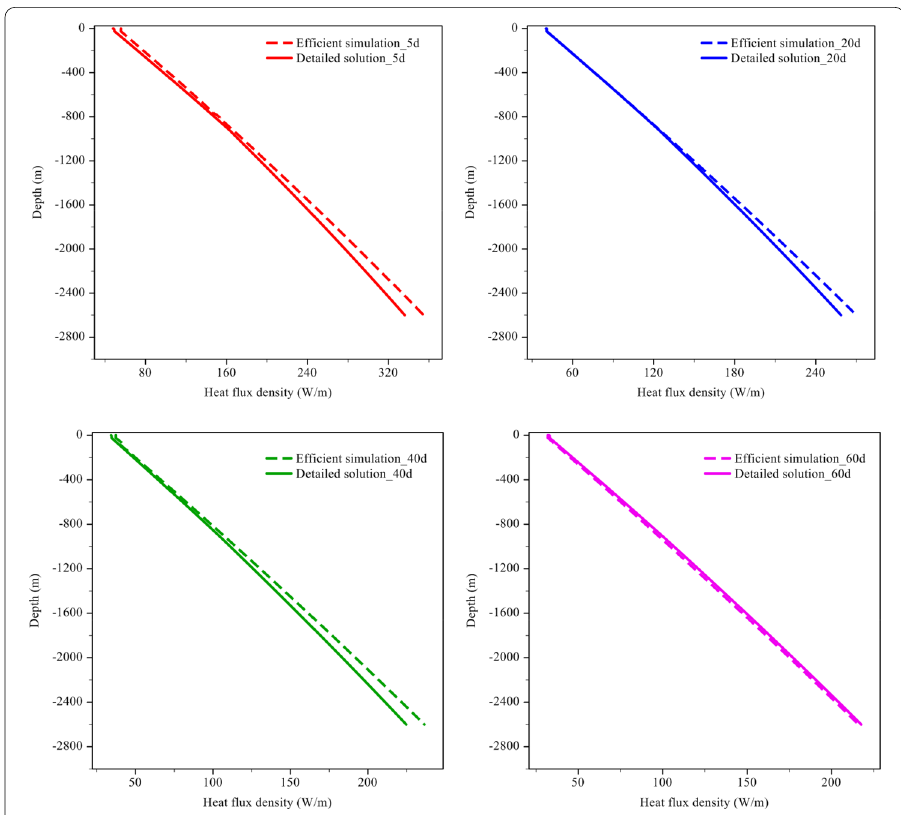
Fig. 11 Comparison of simulation results of extracted heat flux density distribution along borehole with depth during the heating